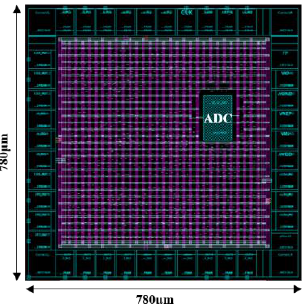
Figure 10. The layout of this work.